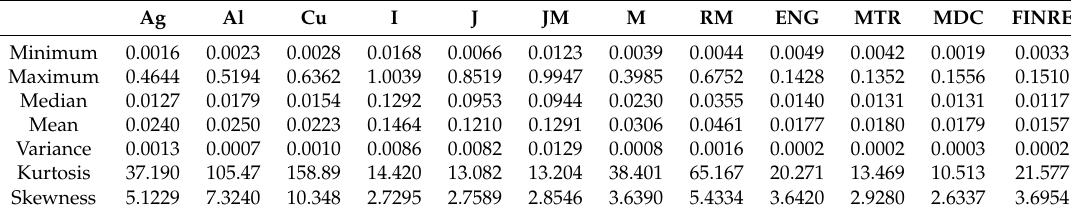
Table 1. Summary statistics of RRV for each product.